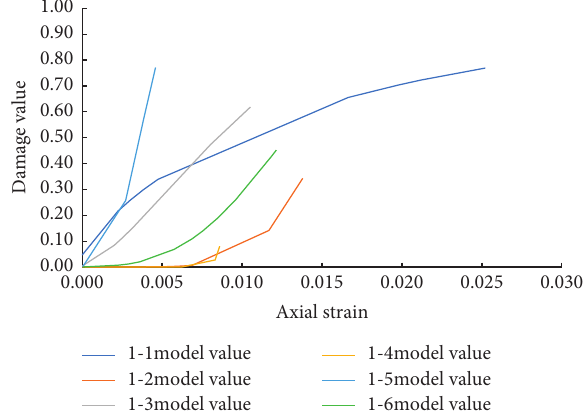
Figure 8: D − ε theoretical curve of filled cracked rocks with gypsum mortar. 1 t